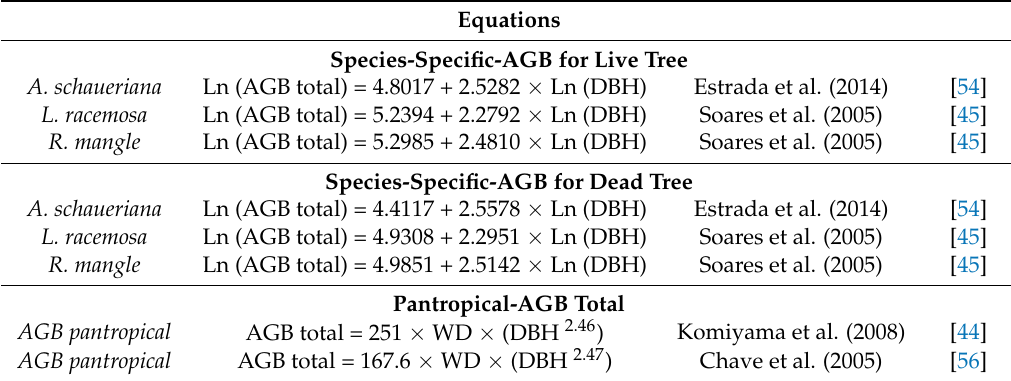
Table 1. Mangrove aboveground biomass (AGB) equations, using diameter at breast height (DBH) and wood density